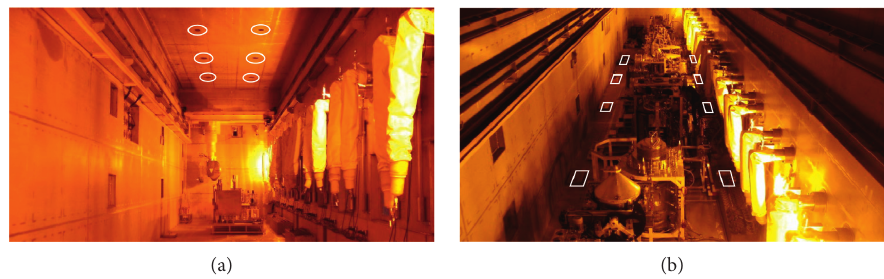
Figure 3: Inside the area of PRIDE argon cell, including ports for argon flow.